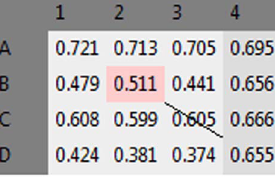
Figure 5. Edit data window. This window allows the user to change or discard particular values from the analysis. Any changes will be noted in the final report.